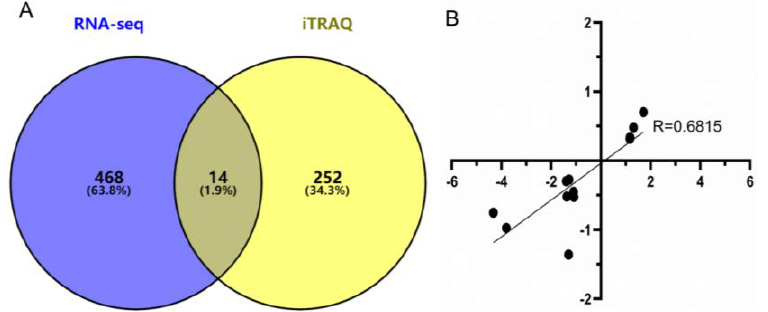
Figure 6. Bi-omics of the co-expressed genes/proteins. Transcriptome confirmation using real-time RT-qPCR [results represent means ± S.E.M.] ( A ); log2 fold changes in gene expression for the RNA-Seq and iTRAQ, which are closely correlated [R = 0.6815; p = 0.0005] ( B ).